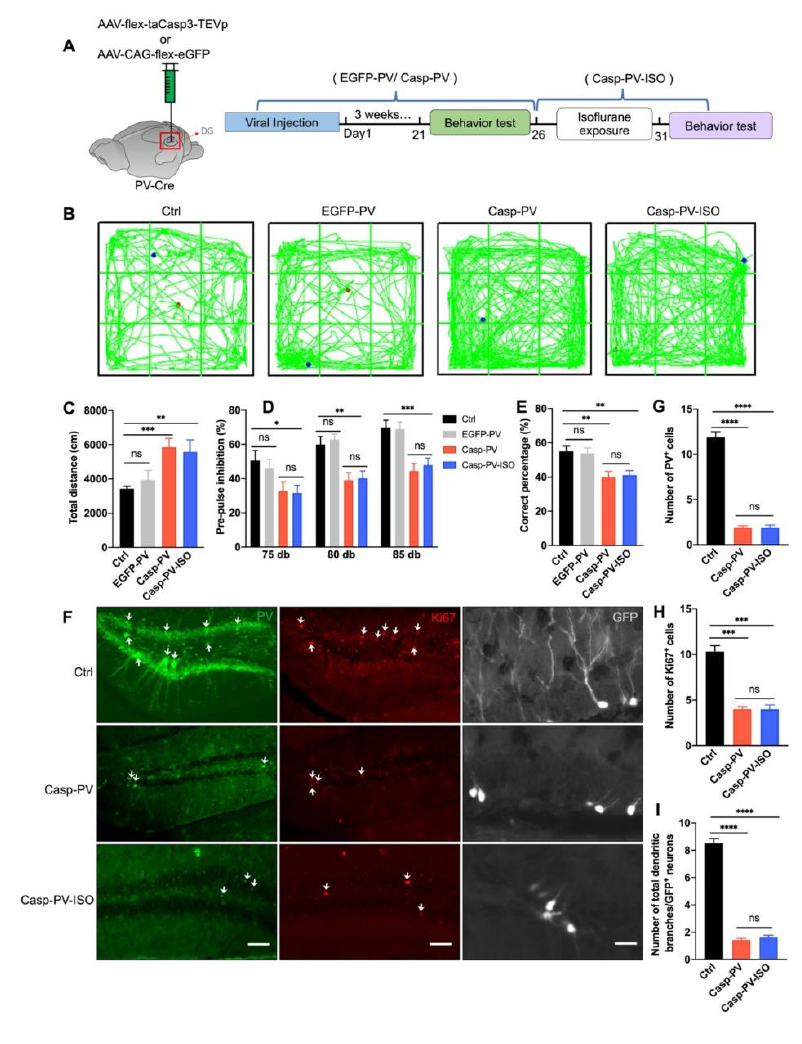
Figure 5. Isoflurane cannot improve schizophrenia-like phenotypes and neurogenesis induced by PV neurons ablation in the DG. ( A ) PV-cre mice were stereotaxically injected with AAV-flex-tsCasp3-TEVp (Casp-PV) to ablate PV neurons in the DG, AAV-CAG-flex-eGFP injected mice (EGFP-PV) was used as control. Schematic experimental design is shown in the right panel. ( B ) Representative traces of mice in the OFT. ( C ) Isoflurane treatment could not reverse the hyper-locomotion phenotype after PV ablation, as revealed by OFT ( n = 10, 10, 9 and 10 mice in Ctrl, EGFP-PV, Casp-PV, and Casp-PV-ISO groups, respectively. One-way ANOVA, F (3, 25) = 5.737, p = 0.004; post hoc test: Ctrl vs. EGFP-PV, p = 0.37; Ctrl vs. Casp-PV, p = 0.0003; Ctrl vs. Casp-PV-ISO, p = 0.007; Casp-PV vs. Casp-PV-ISO, p = 0.75). ( D ) Isoflurane could not rescue the pre-pulse inhibition deficit induced by